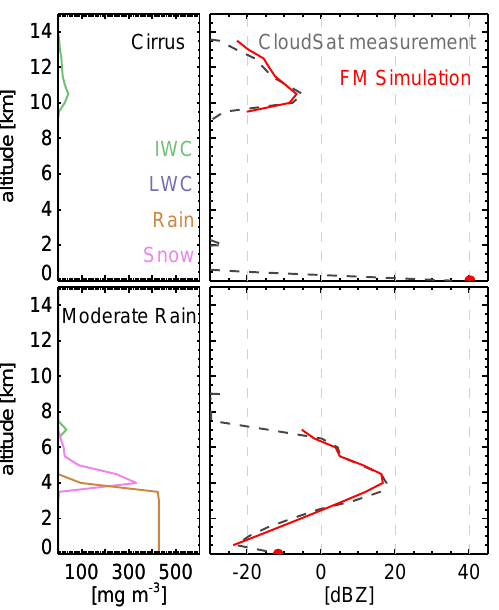
Figure 2. Comparisons between CloudSat measurements and for- ward model simulations. Forward model simulations are only shown for those altitudes with hydrometeors; the surface return is represented by a dot. For a detailed description see Sect. 3.6.